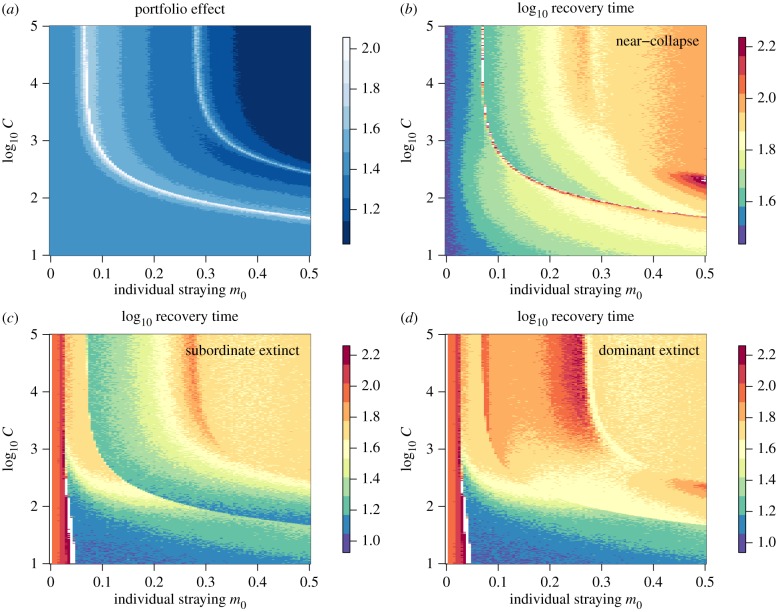
Measures of metapopulation robustness for the density-dependent straying model as a function of individual straying m0 and the strength of collective behaviour C (note the log10 scale, including (a) the portfolio effect, (b) the time to recovery following near-collapse of both populations, (c) the time to recovery following the extinction of the subordinate population and (d) the time to recovery following the extinction of the dominant population. (Online version in colour.)